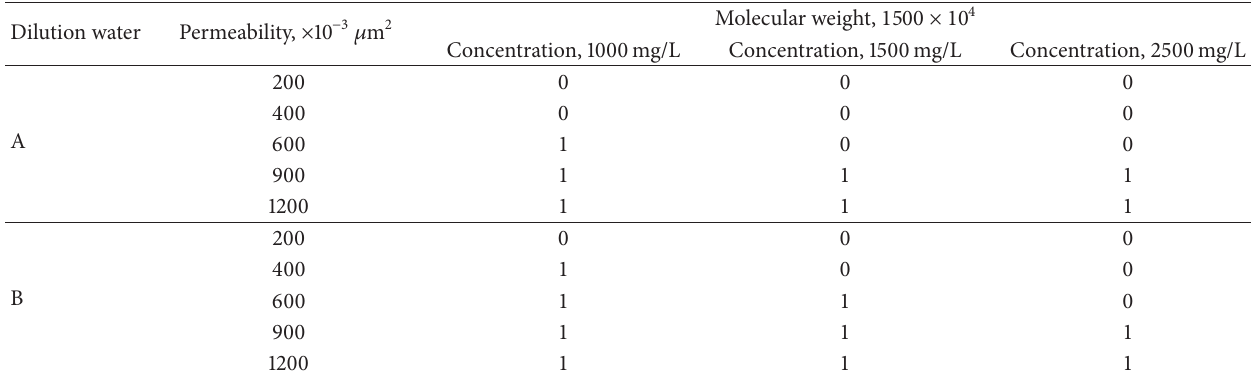
Table 3: The core flow matching relationship plate.